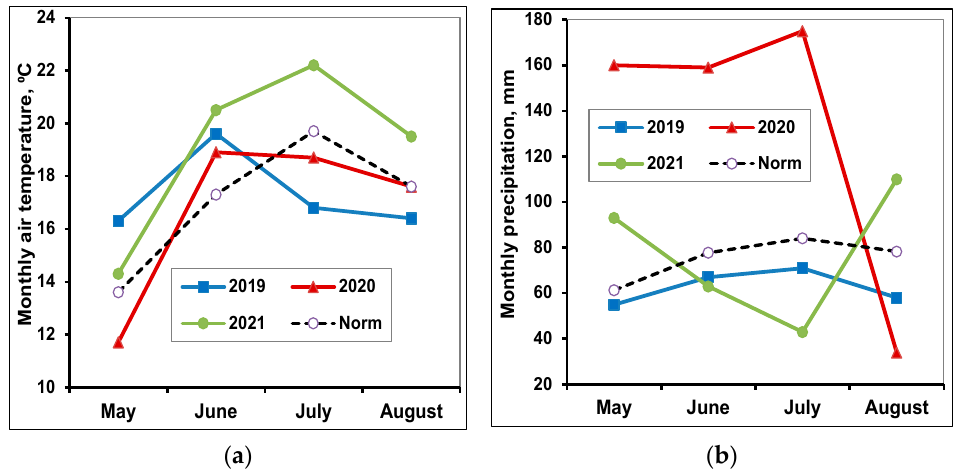
Figure 9. Meteorological conditions in the warm months of 2019–2021 in Moscow in comparison with the norms [48]: ( a )—the monthly average air temperature in near-surface air; ( b )—the total monthly precipitation.